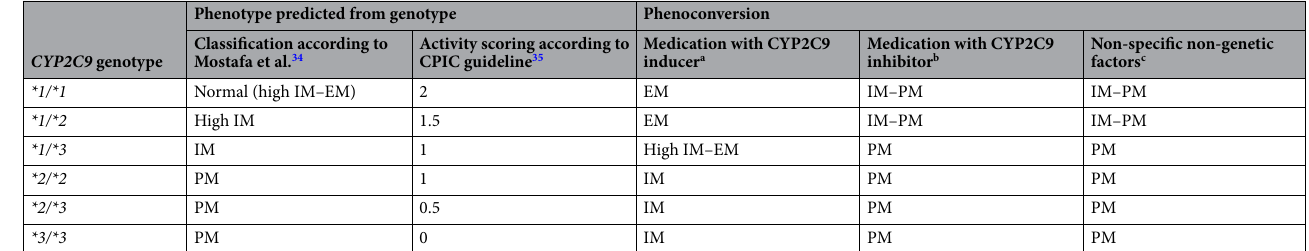
Table 3. Genotype-based prediction of CYP2C9 metabolizer phenotypes and phenoconversion by non- genetic factors. PM poor metabolizer, IM intermediate metabolizer, EM extensive metabolizer, CPIC Clinical Pharmacogenetics Implementation Consortium. a CYP2C9 inducers: dexamethasone, methylprednisolone, midazolam. b CYP2C9 inhibitors: amlodipine, tamoxifen. c Non-specific factors: chronic alcohol consumption, amoxicillin + clavulanic acid